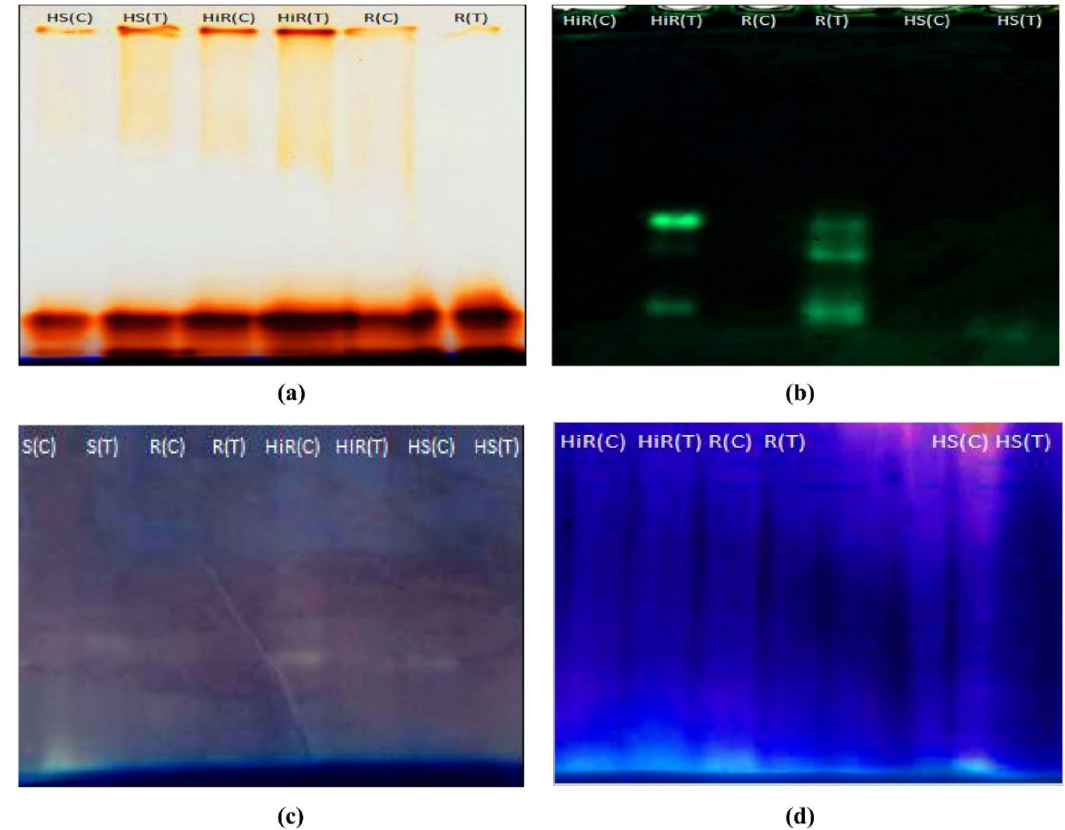
Figure 3. Gel activity detection, ( a ) POD activity gel image, ( b ) CAT activity gel image, ( c ) SOD activity gel image, ( d ) APX activity gel image in HiR, R, S and HS chili varieties in the absence and presence of X. spp. The sample loading amount used in each line was 80 µg protein. R resistant, HiR highly resistant, S susceptible, HS highly susceptible, C control, T treatment